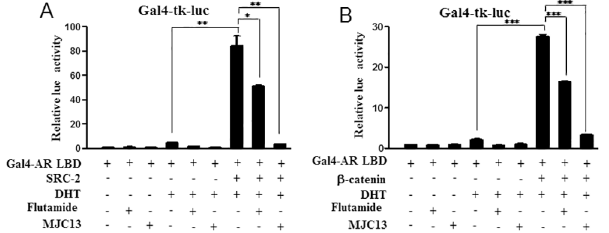
+/- DHT (1nM) and +/- Flutamide (1 μ M) or +/- MJC13 (30 μ M) overnight. The data are representative of at least three independent experiments. All values represent the mean ± SD of duplicate samples. Transfections employed 100ng of Gal4-tk-luc, 50ng of Gal4-AR LBD, 400ng of SRC-2, 100ng of β -gal in Fig 9A and 100ng of Gal4-tk-luc, 50ng of Gal4-AR LBD, 400ng of b-catenin, 100ng of β -gal in Fig 9B.